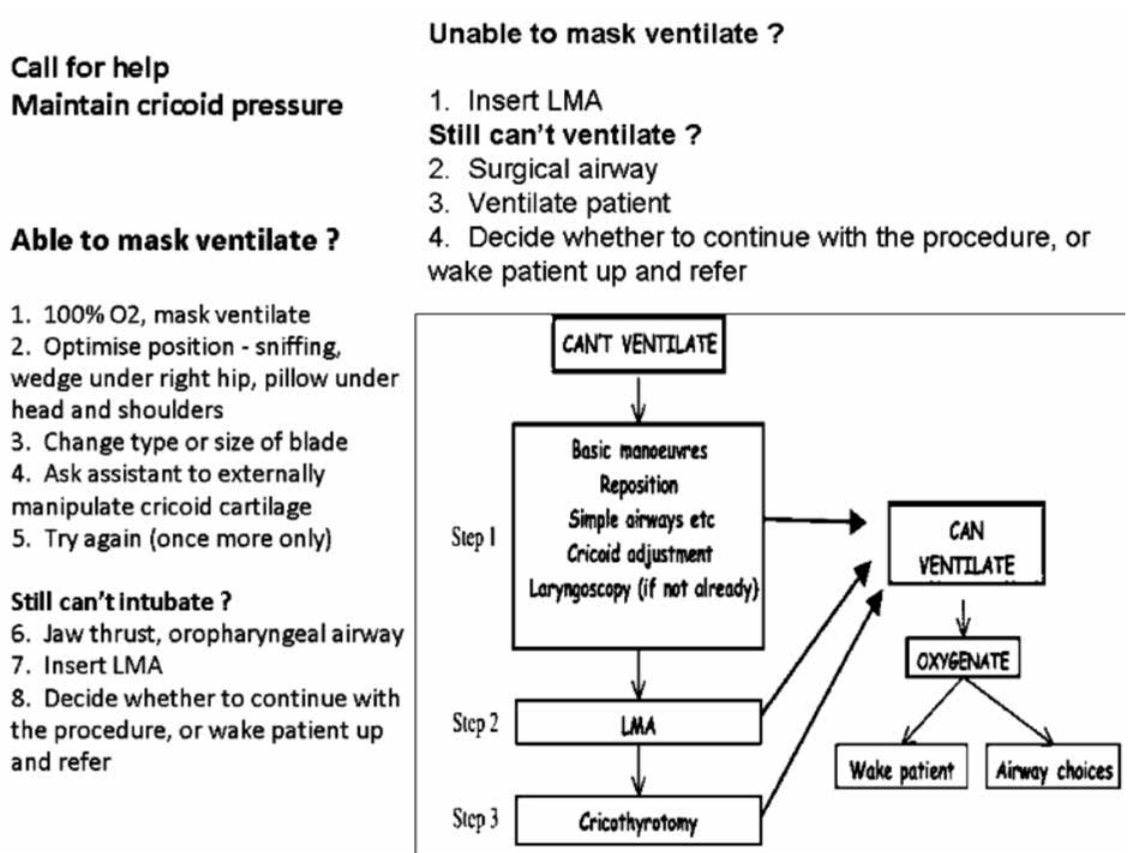
Figure 2: Flow diagram of immediate management if patient airway and mask ventilation cannot be